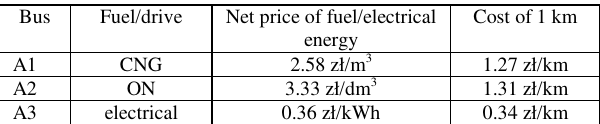
Table 2. Comparison of costs per 1km in tested buses in terms of fuel/energy